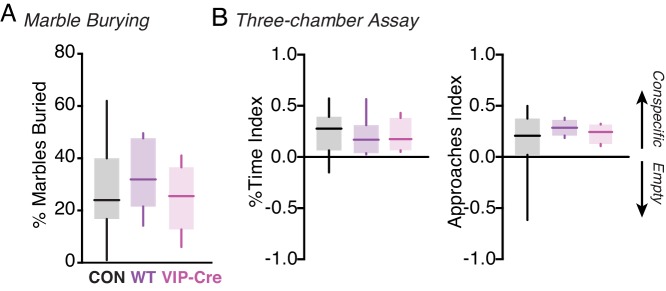
No difference in behavior among control groups.(A) Mean percentage of marbles buried by Mecp2f/y controls (n = 16), wild-types (n = 5), and VipCre controls (n = 4). (B) Left: preference index for time spent with an unfamiliar conspecific in a small holding cage versus time spent in an empty cage for Mecp2f/y controls (n = 16), wild-types (n = 6), and VipCre controls (n = 4). Right: preference index for approaches made to within 5 cm of the conspecific or the empty holding cage for each group.